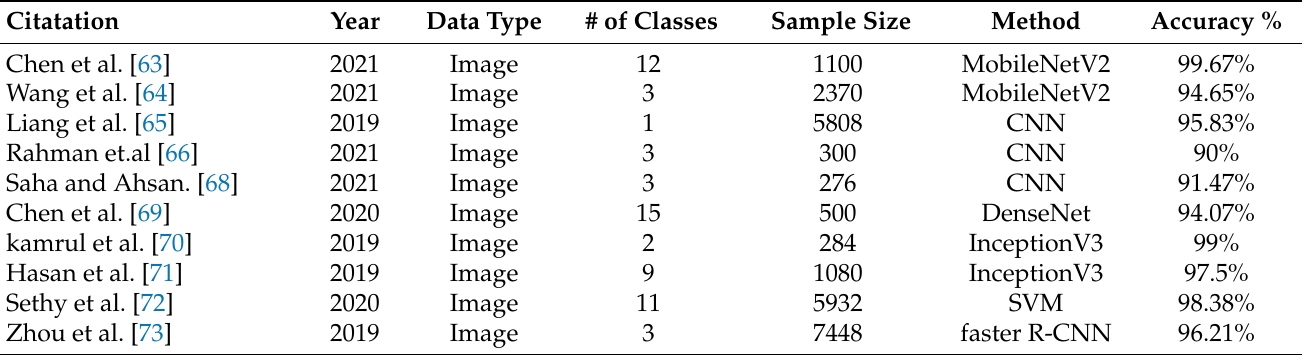
Table 12. Performance comparison of selected studies on machine learning based rice disease detection and corresponding